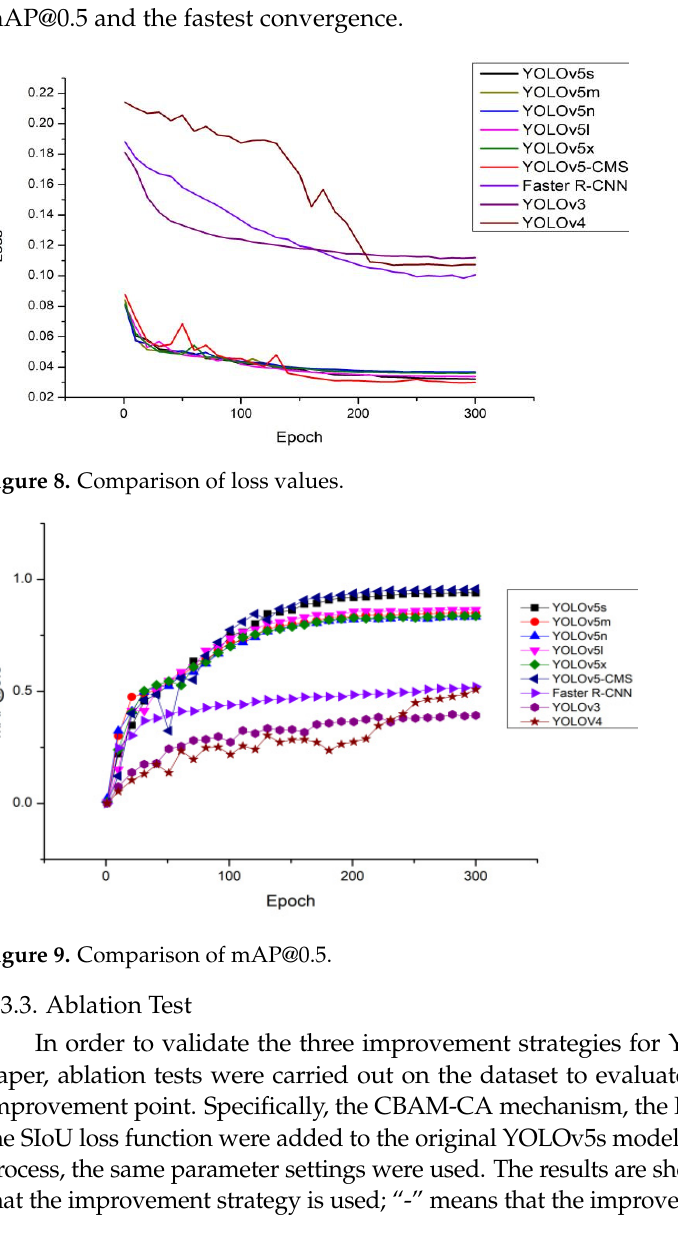
Table 5. Comparison of models during ablation tests.